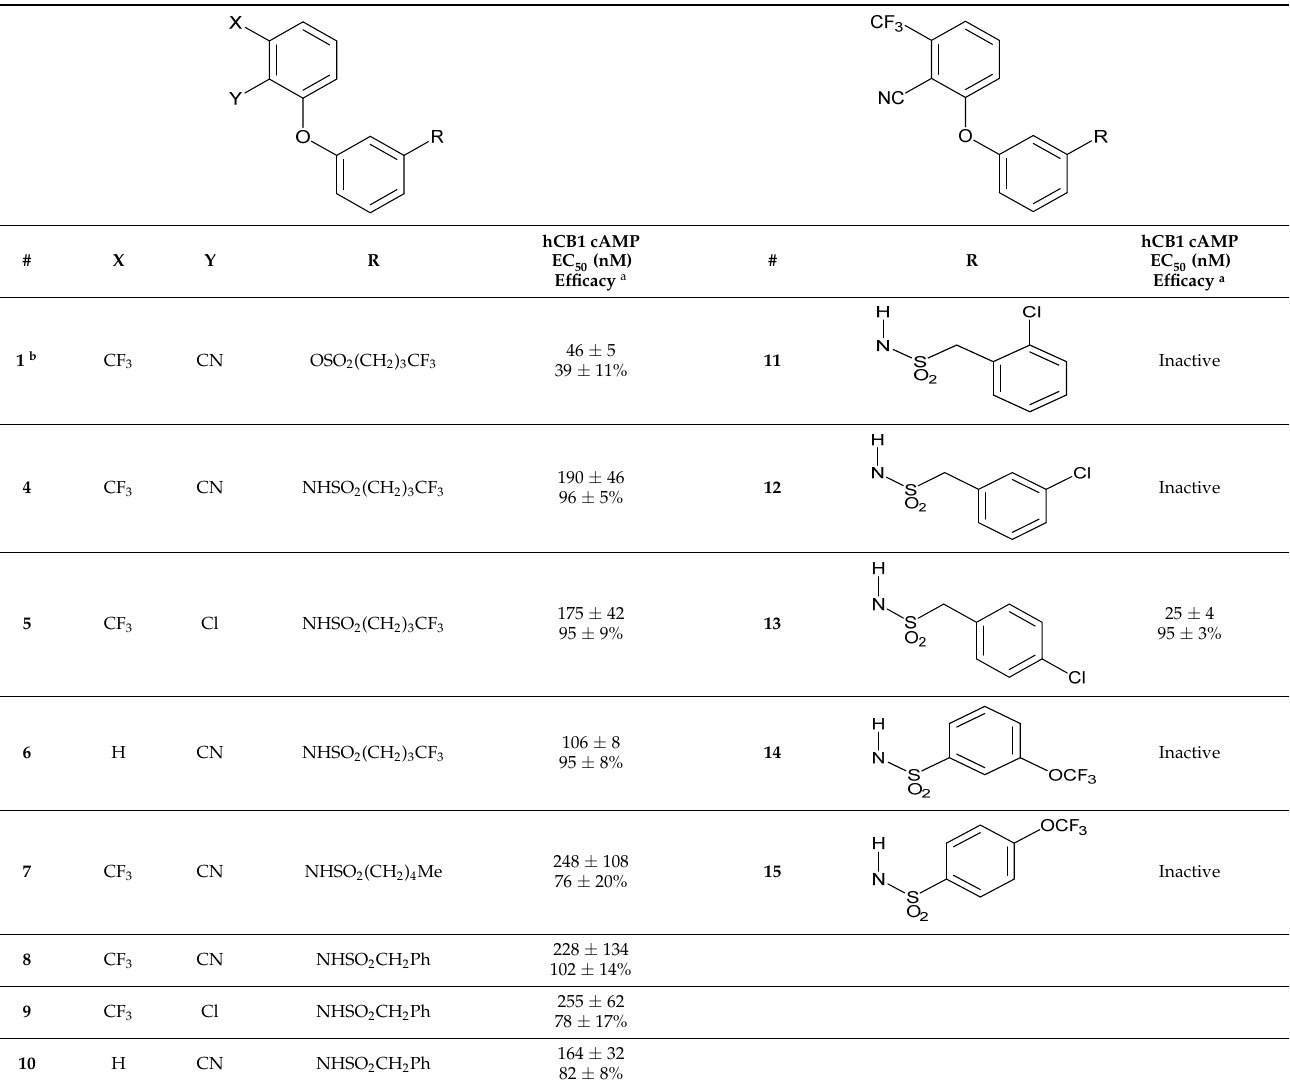
Table 1. Sulfonamide analogs of 1.